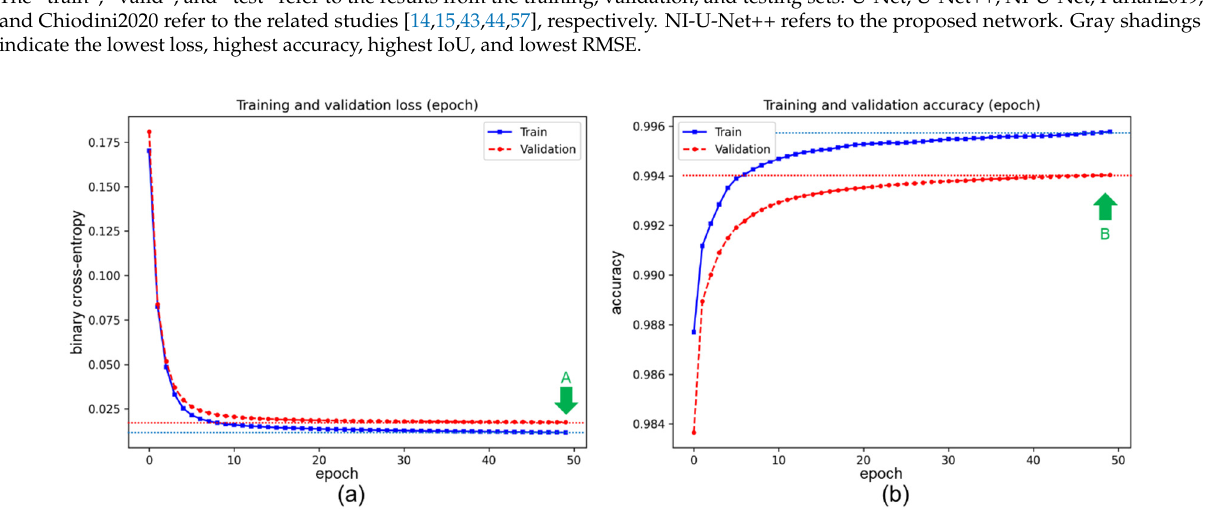
Figure 8. The ROC curves of the proposed NI-U-Net++, Furlan2019 [43], and Chiodini2020 [44]. The gray shadings in Table 5 and Table A2 highlight the best results in each column. NI-U-Net and NI-U-Net++ show better performances than the U-Net and U-Net++ with a lower “loss” value and higher “accuracy”, “IoU”, and “Dice” values. This suggests that the proposed micro-network helps to improve the performance of rock segmentation. Moreover, Figures 6 and A6 both appear to have a more rapid initial learning speed com- pared to Figures A4 and A5. Thus, the proposed micro-network can accelerate the learn- ing efficiency. The NI-U-Net achieves the highest training accuracy (see Table 5). Arrow “A” in Fig- ure A6a highlights a U-shaped rise that appears on the validation loss curve, while the training loss curve keeps decreasing. These indicate that overfitting occurs for NI-U-Net. This can explain that NI-U-Net achieved the lowest training loss and highest training ac- curacy, but the validation and testing loss and accuracy were poorer than others. The green arrow “B” in Figure A6b indicates that NI-U-Net produces the largest distance in accuracy between the training and validation sets. NI-U-Net is a modified U-Net using the micro-network. Compared with U-Net, all the results of NI-U-Net achieve improve- ments. Therefore, the proposed micro-network can also suppress the overfitting level. Table 5 and arrow “A” in Figure A4a find that U-Net achieves a higher loss and lower accuracy. Thus, U-Net has the highest level of underfitting. Arrow “B” in Figure A4b high- lights that accuracy curves keep flat at the first two epochs. This indicates that the learning process of U-Net is difficult. This comes from a fixed and high encoder ratio. The down- sampling operations in the encoder can cause significant information loss, especially for small targets.